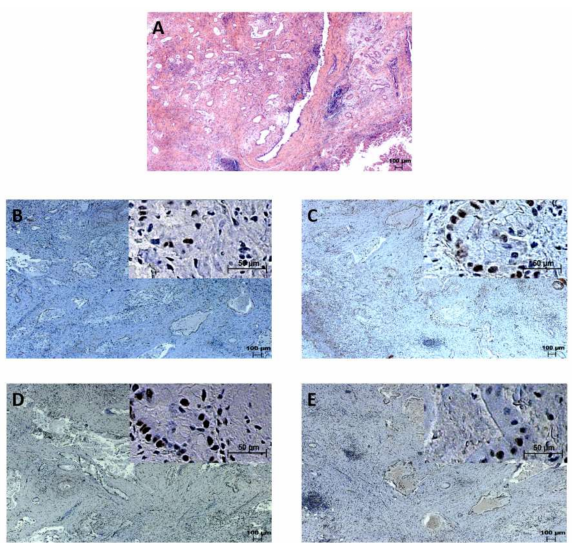
Figure 2. Extrahepatic cholangiocarcinoma staining. ( A ): Hematoxylin and eosin (HE) staining. Samples immunohistochemically positive for ( B ): PMS2, ( C ): MLH1, ( D ): MSH6, ( E ): MSH2.